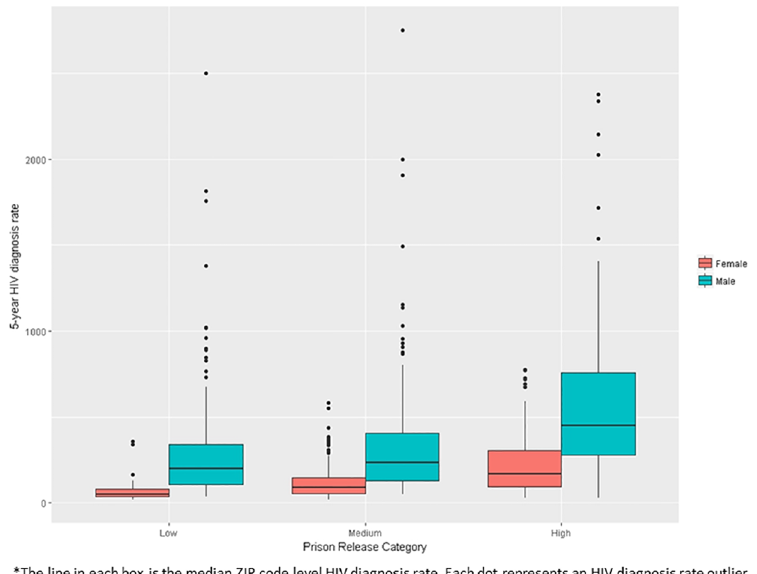
Fig 3. Boxplots of 5-year HIV male and female diagnosis rates by prison release category (low, medium, high) (cid:3) .